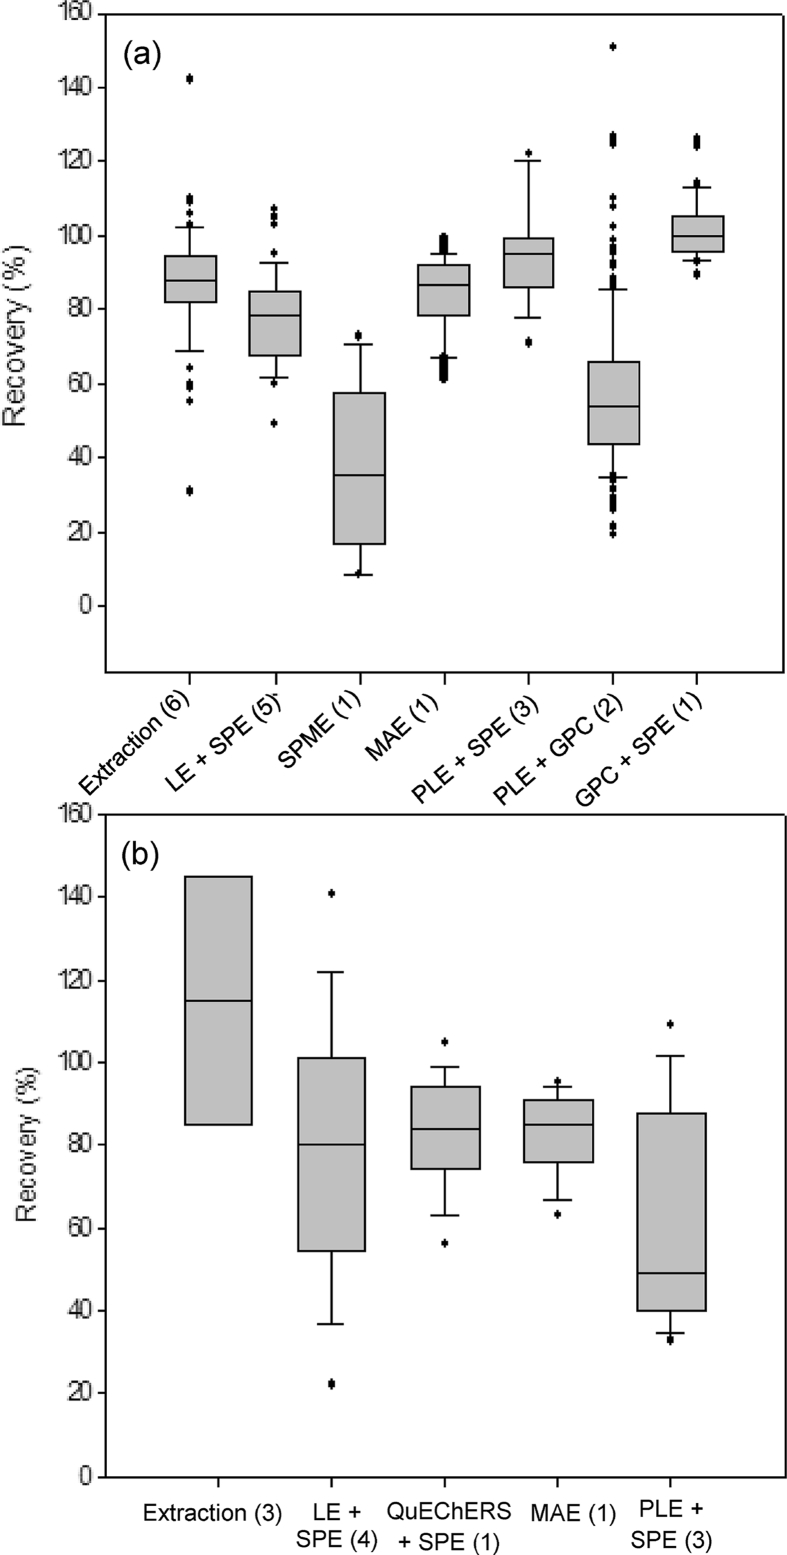
Comparison of reported recoveries for pharmaceuticals using different sample preparation methods determined in (a) fish and (b) invertebrates. Extraction indicates the use of liquid extraction only followed by either centrifugation and/or filtration. Boxes represent the 25th, median and 75th percentile, whiskers represent 10 and 90th percentile and dots indicate outliers. Parentheses indicate the number of studies for each method.